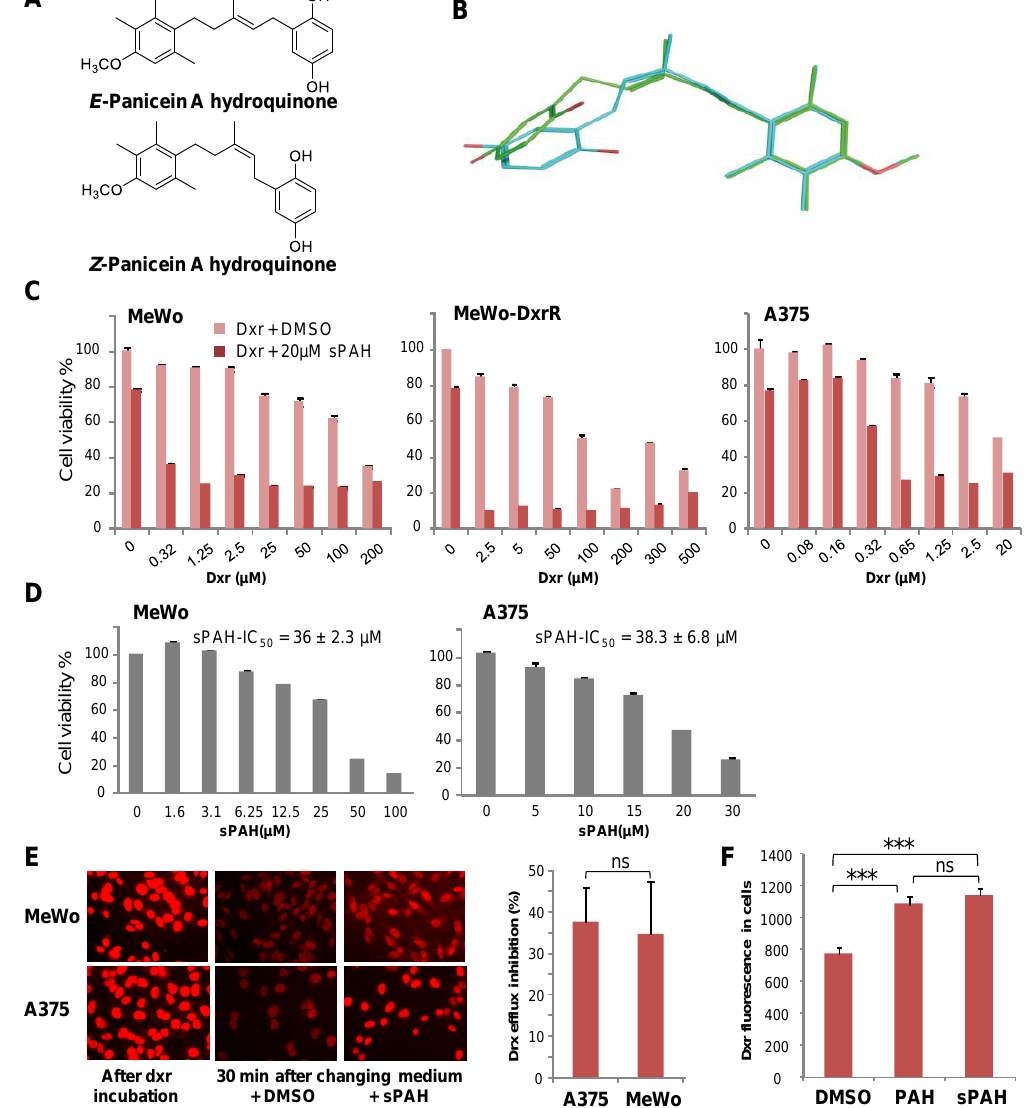
Figure 2. The chemically synthesized PAH is as effective as natural PAH in increasing cytotoxicity and inhibiting the efflux of doxorubicin . ( A ) Stereoisomers of PAH . ( B ) 3D structures of E and Z forms of PAH are very similar . The E form is in green and the Z form is in cyan. ( C ) sPAH increases doxorubicin cytotoxicity in various melanoma cell lines. Cell viability was measured after treatment with increasing concentrations of dxr in the presence of DMSO or 20 µM sPAH on MeWo cells, MeWo cells rendered resistant to dxr (MeWo-DxrR) and A375 cells. ( D ) sPAH cytotoxicity against melanoma cells. Cell viability was measured after treatment with increasing concentrations of sPAH on A375 or MeWo cells. The mean sPAH-IC 50 values calculated from 3 independent experiments are represented. ( E ) sPAH inhibits the dxr e ffl ux activity of Ptch1. A375 or MeWo cells were seeded on coverslips and